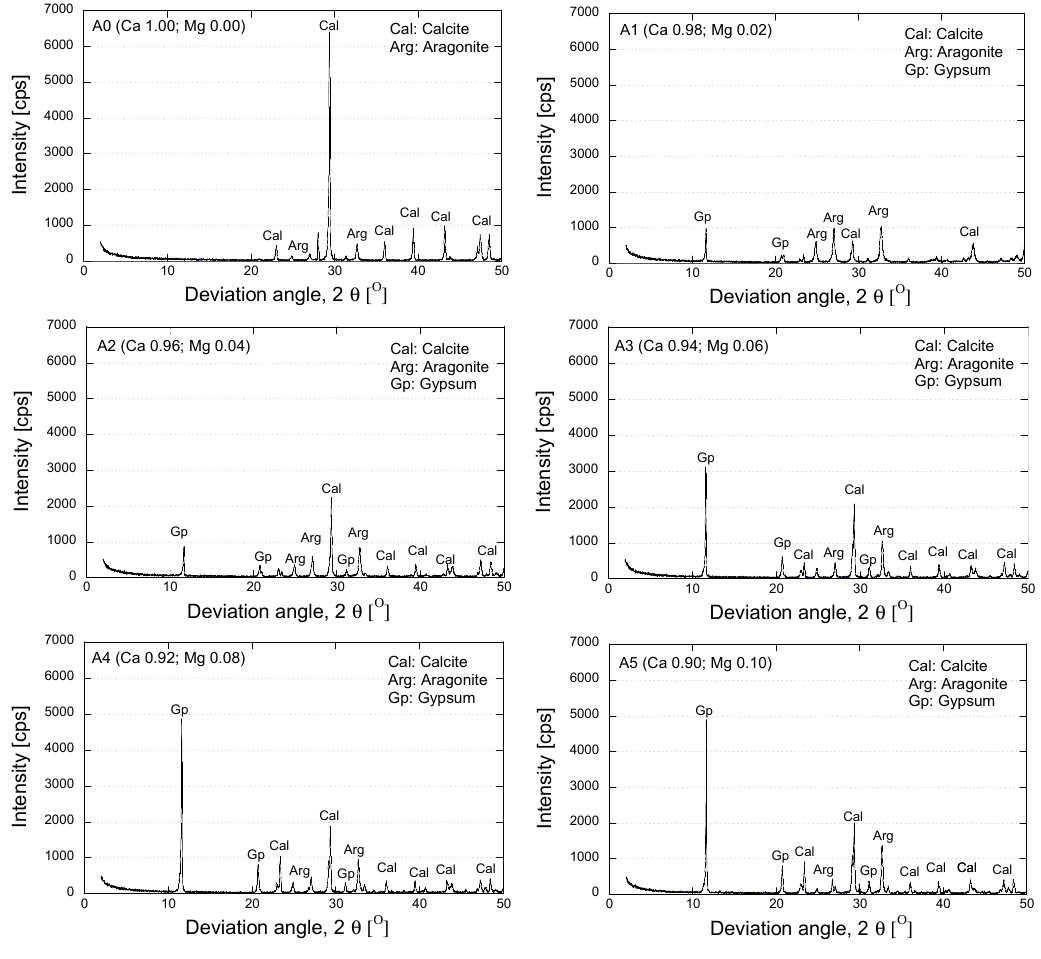
Figure 5. X-ray diffraction results of precipitated materials.